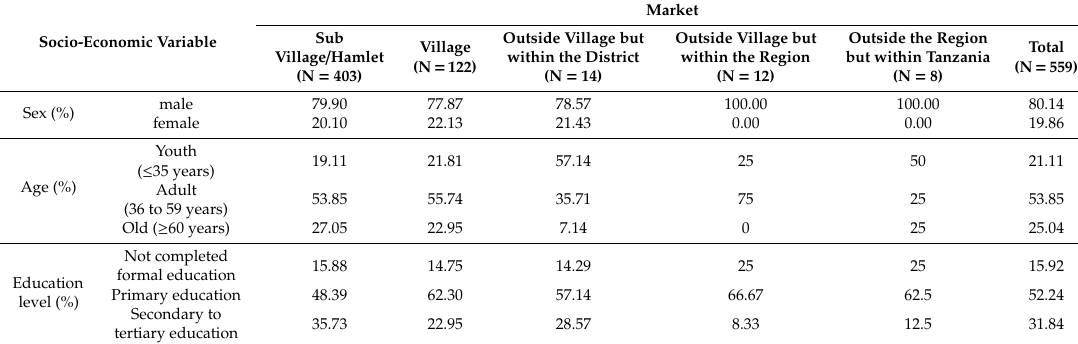
Table 2. Characteristics of plot managers involved in the